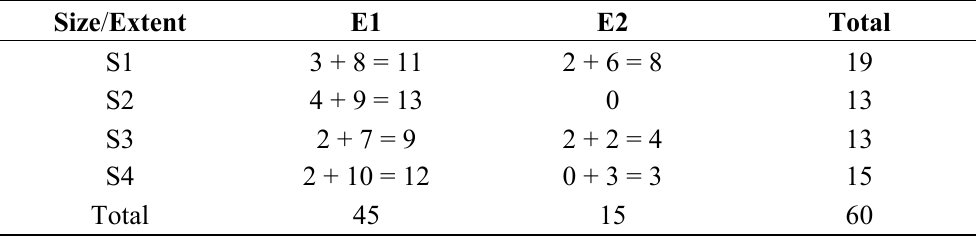
Table 1. Summary table of counts of weathering forms (N =